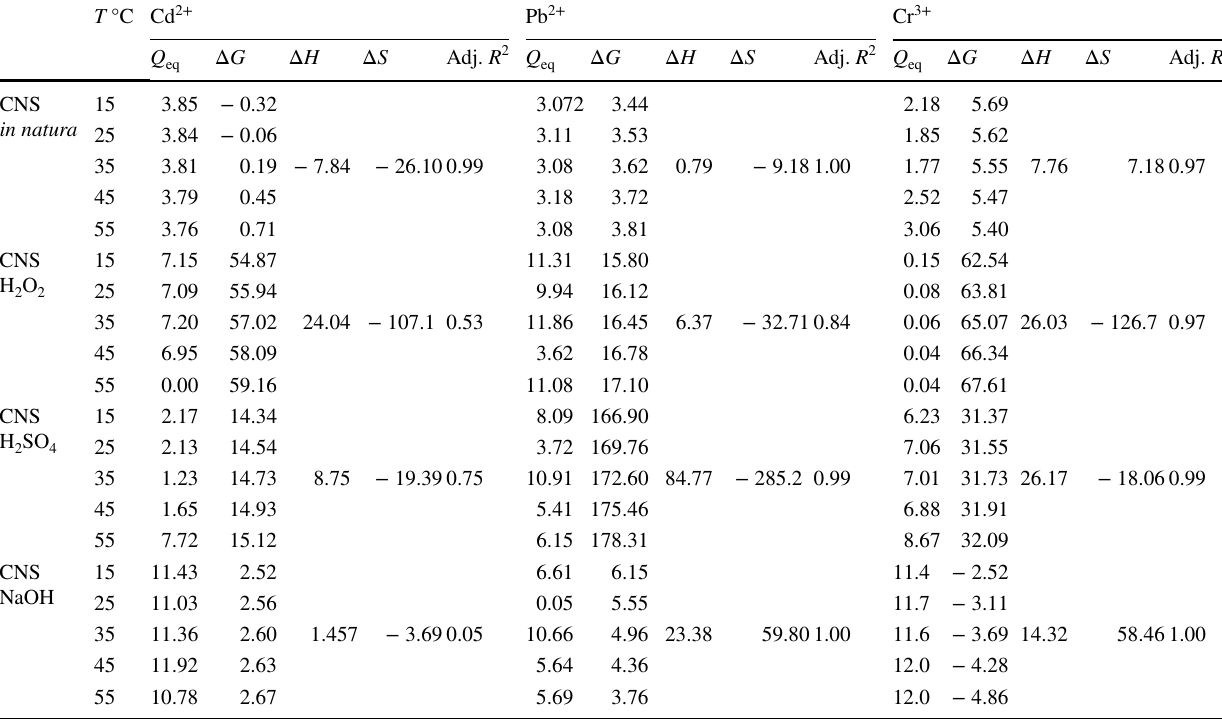
Table 10 Q eq obtained values and thermodynamic parameters for adsorption of Cd and chemically modified with H 2 O 2 , H 2 SO 4 and